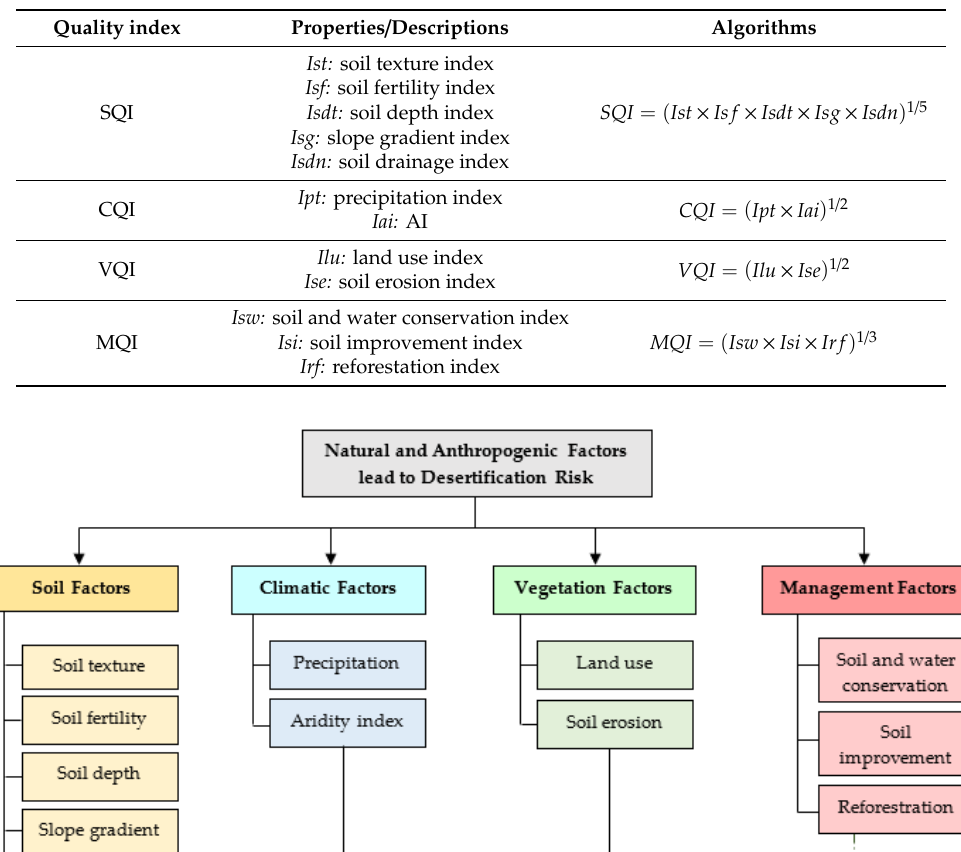
Table 2. Environmental properties related to desertification sensitivity indexes.